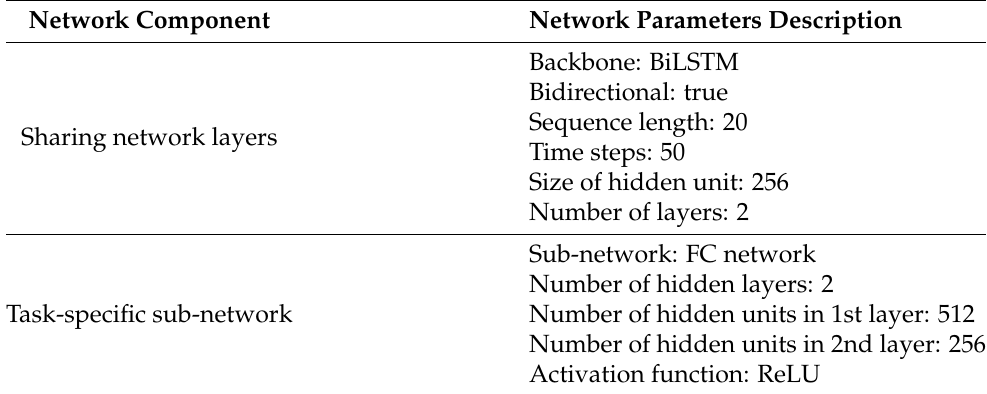
Table 1. Configuration of The Adaptive Weight Learning-based Multitask